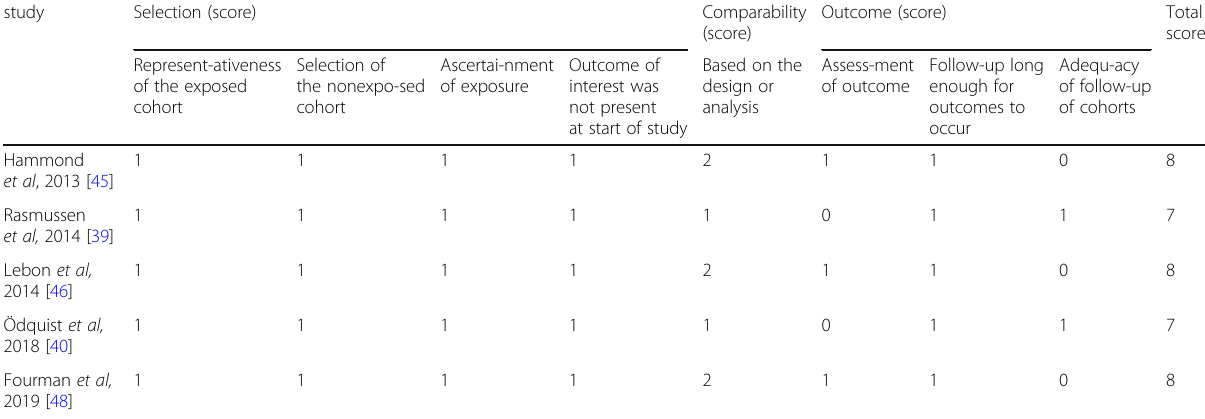
Table 3 Methodological assessment based on Newcastle-Ottawa Scale for non-randomized studies